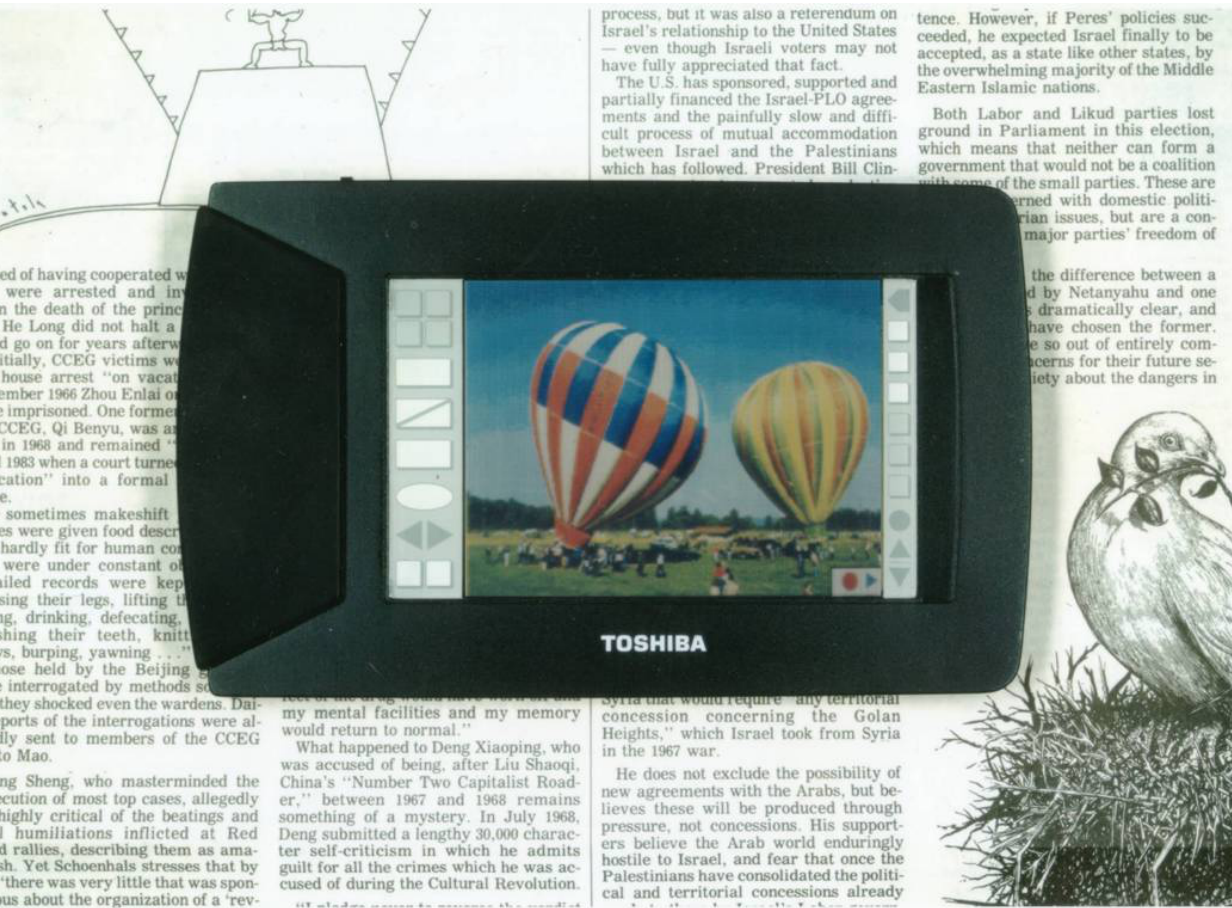
Figure 22. The color image of the reflective three-layer GH-LCD (the LCD is on a newspaper. Large reflectance in white state (43 %) is demonstrated.)